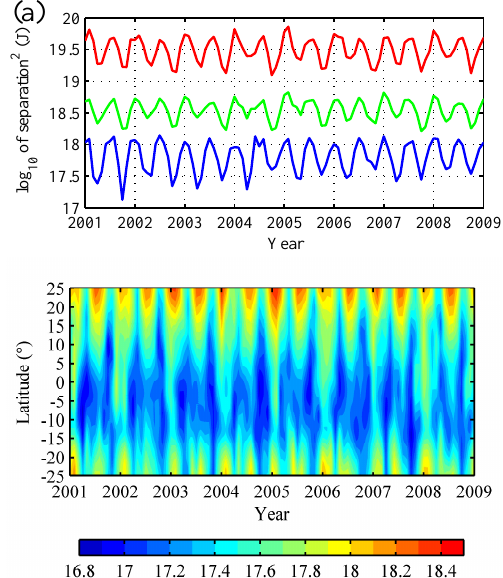
Figure 7. (a) Kinetic (red), enthalpy (green) and surface pressure (blue) separation-squared between CFSR monthly mean data and its annual mean climatology in the tropical region (25 ◦ S–25 ◦ N) up to 100mb. (b) Time–latitude cross-section of the logarithm to base 10 of the total separation-squared integrated zonally and vertically up to 100mb in the tropical